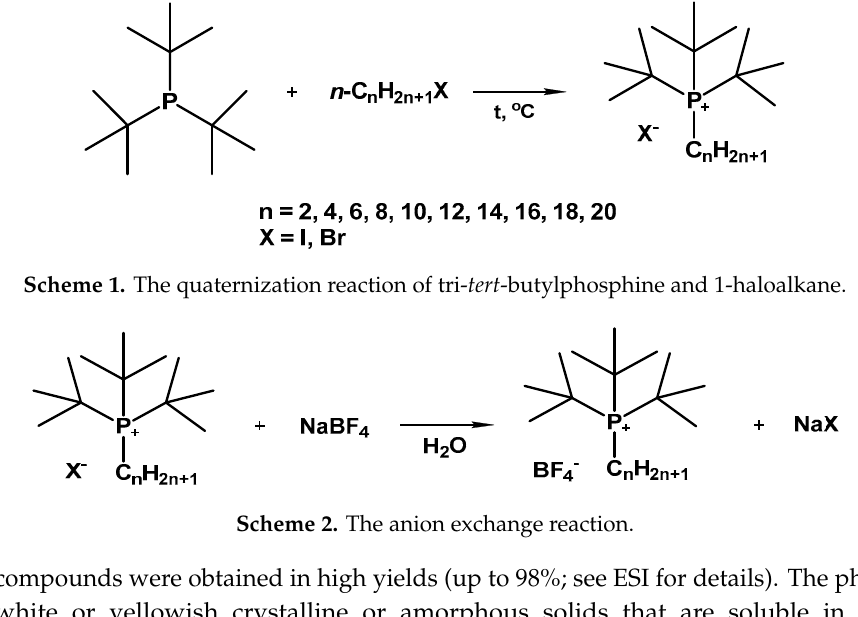
Table 1. 1 H NMR chemical shifts ( δ (ppm), CDCl 3 , 400 MHz, 20 °C) and 31 P{ 1 H} NMR shifts ( δ (ppm), CDCl 3 , 161.7 MHz, 20 °C.